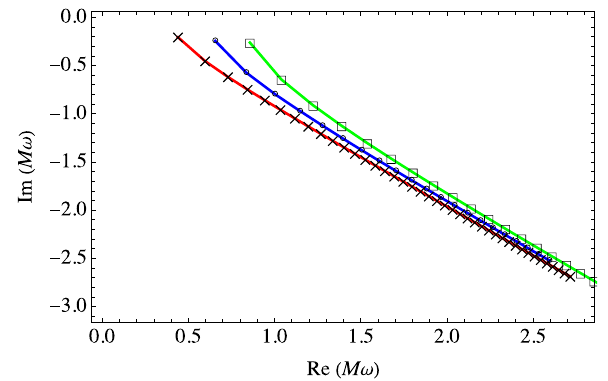
Fig. 6 The spectrum of the QNMs for (cid:16) = 2 (red), (cid:16) = 3 (blue), and (cid:16) = 4